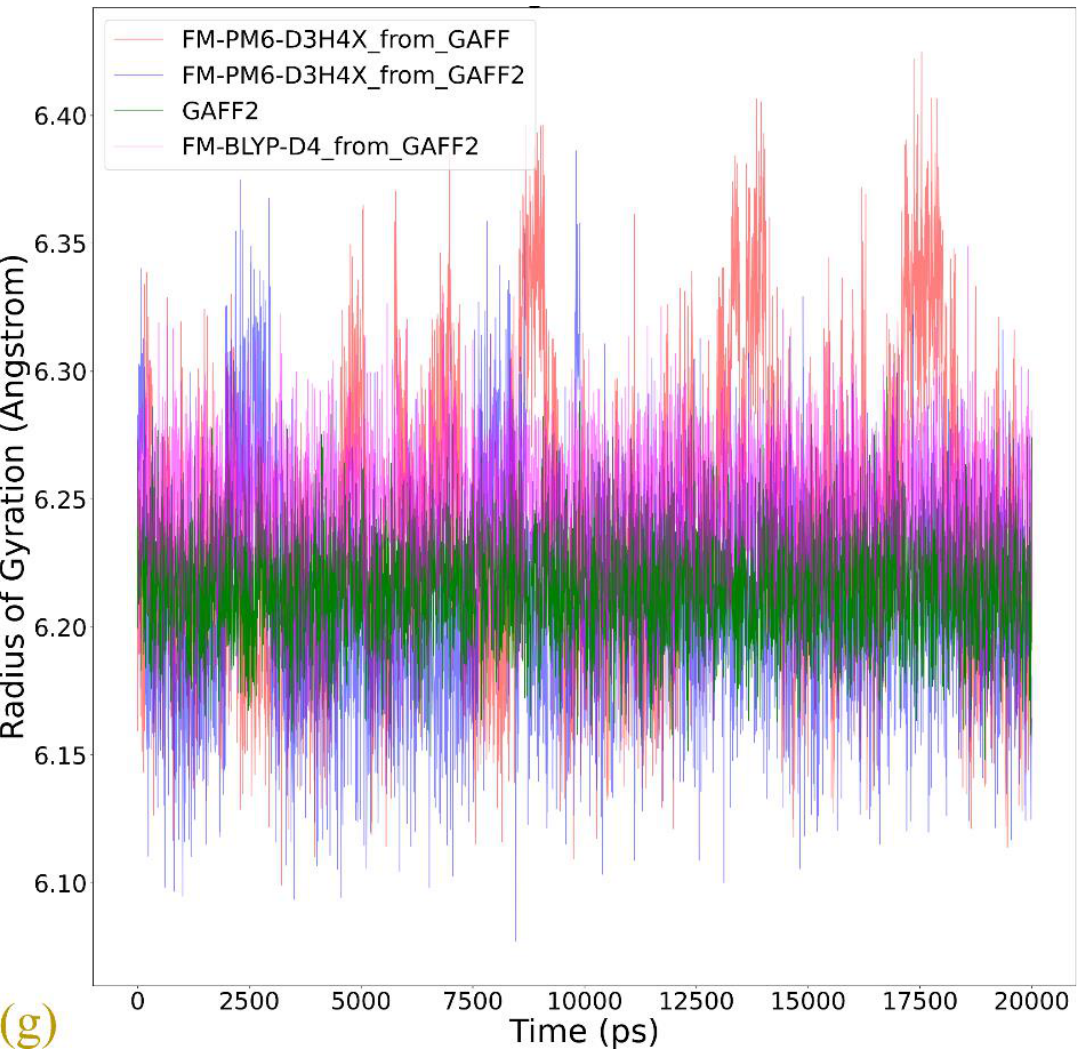
Figure 4. ( a ) The dihedral term that shows the most significant difference between GAFF derivatives describing the conformational preference (stiffness) of the host. The superposition of the host con- figurations during 20 ns unbiased simulations in explicit solvent with bonded parameters from ( b ) GAFF, ( c ) GAFF2, ( d ) the FM-PM6 parameters initiated from GAFF, ( e ) the FM-PM6 parameters initiated from GAFF2, and ( f ) FM-BLYP initiated from GAFF2. ( g ) The time series of the radius of gyration of the CB8 ring under the GAFF2 and the refitted parameter sets.